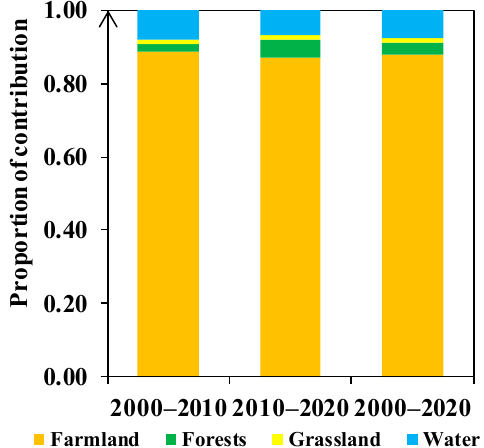
Figure 5. The proportions of contributions to the growth of impervious surfaces in Hangzhou City during different periods.